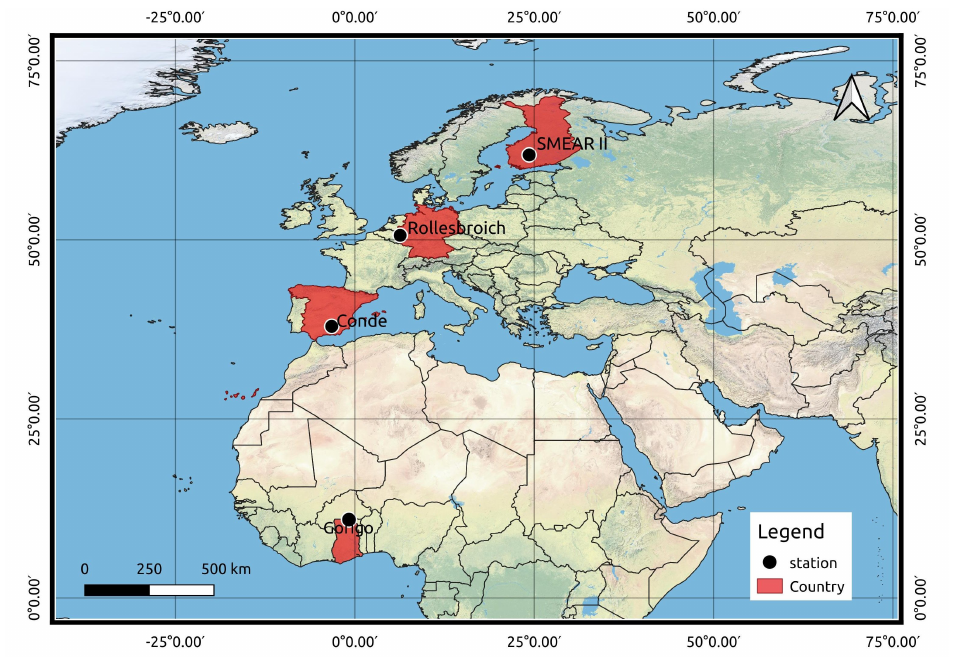
Figure 1. Map showing geographical location of stations used in the study. The countries where stations are located are highlighted in